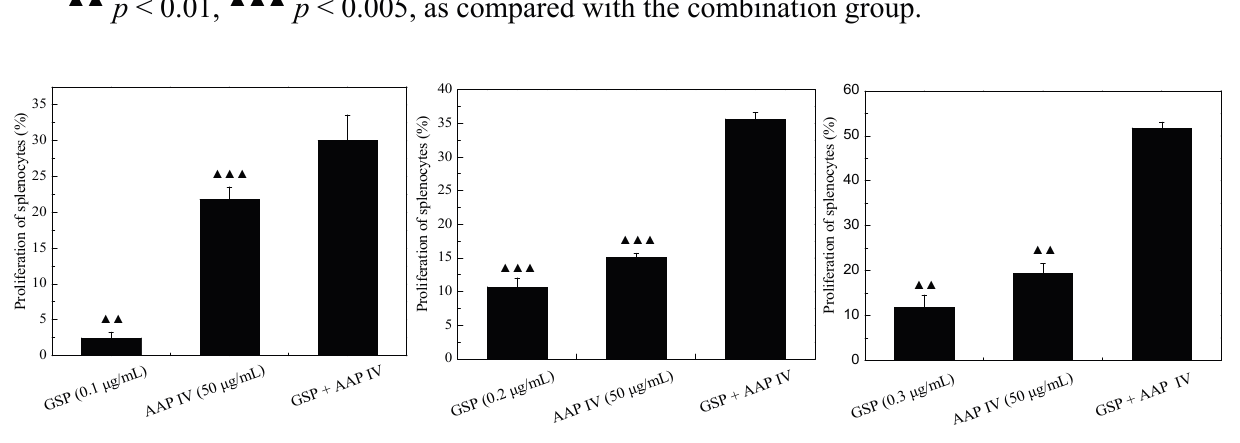
Figure 5. Effect of GSP, AAP IV and their combination on proliferation of splenocytes. ▲▲ p < 0.01, ▲▲▲ p < 0.005, as compared with the combination